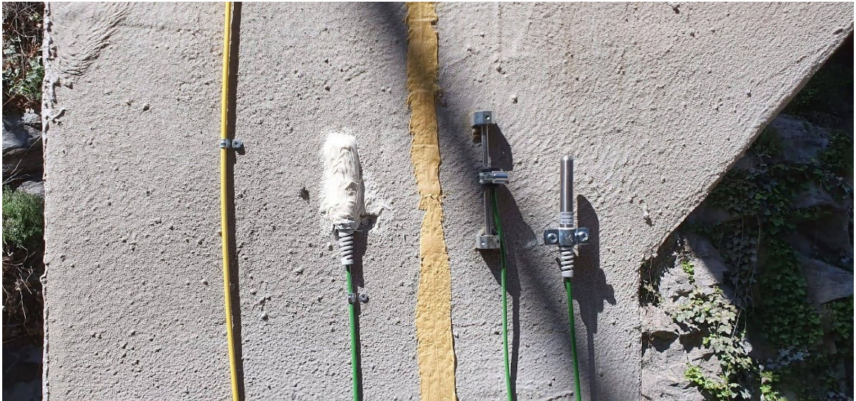
Figure 8. Image of the calibration site A1 installed on the bridge. From left to right: D-FOS tem- perature cable, temperature sensor covered by the polyurethane adhesive, D-FOS strain cable, VW extensometer, and the second temperature sensor not